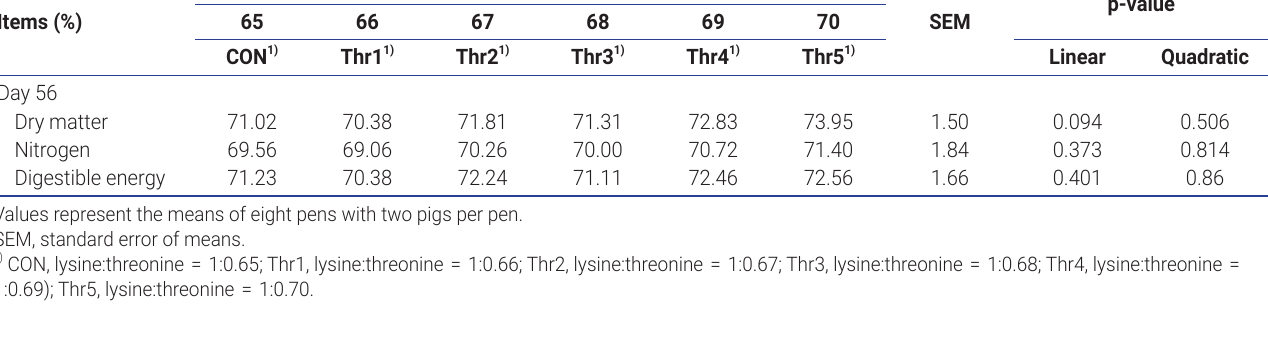
Table 4. Effect of varying dietary Lys:Thr ratios on backfat thickness and lean percentage in finishing pigs Items